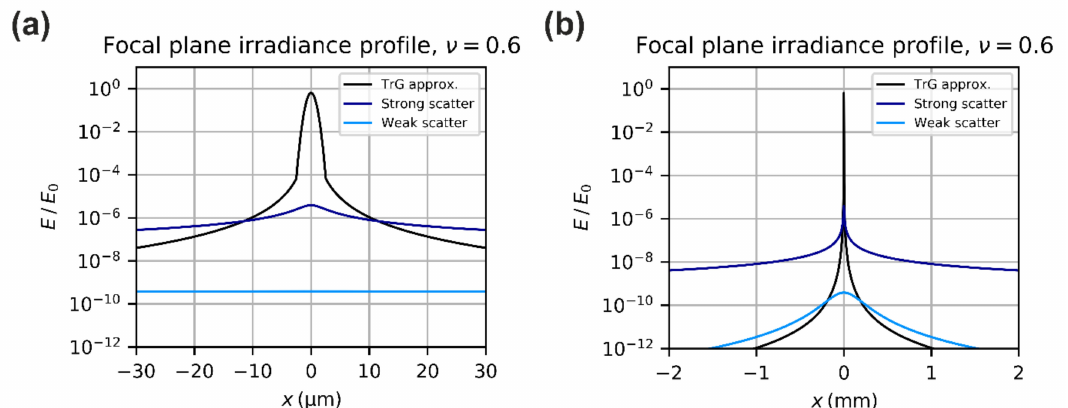
Figure 7. Approximation of the irradiance profile of a truncated Gaussian beam di ff raction pattern according to Equation (23) and irradiance profile of the scattered radiation according to Equation